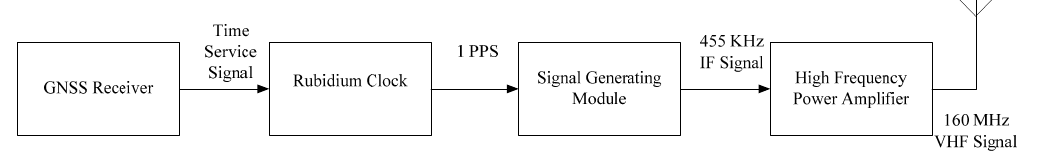
Figure 4. The structure diagram of the transmitter in the ASF correction system.